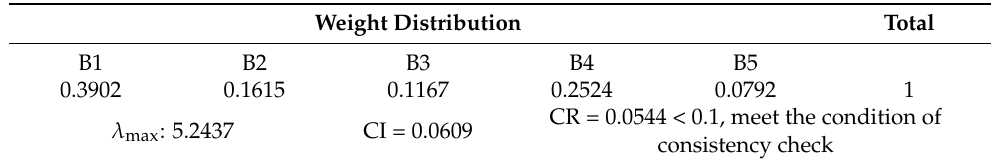
Table 7. The weight distribution for A and